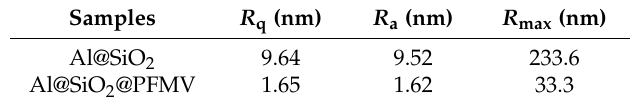
Table 2. The topographical parameters for Al@SiO 2 and Al@SiO 2 @PFMV. Samples